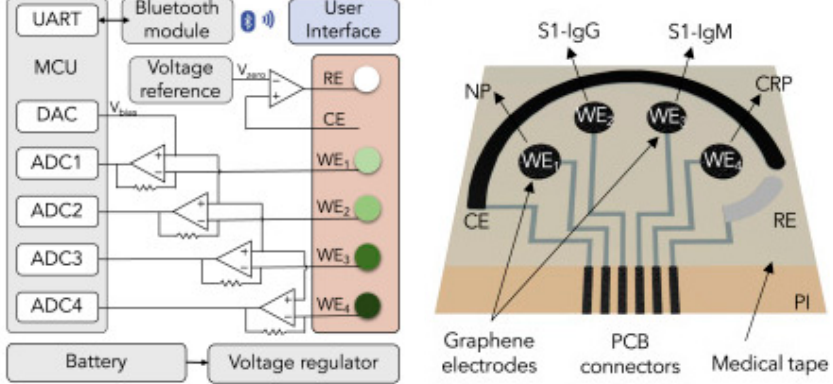
Figure 9. Block diagram of the RapidFlex sensing platform with interface is shown in the left and the sensor array layout is shown on the right. Reproduced with permission from Ref. [15]. Copyright 2020 Cell Press, Elsevier.